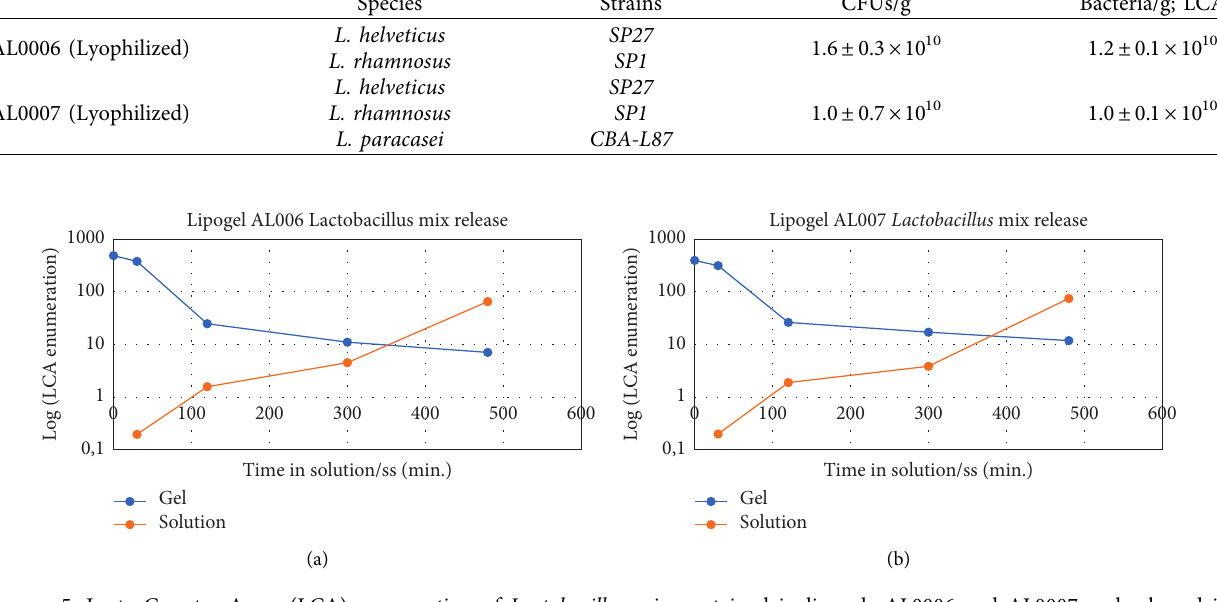
Figure 5: Lacto-Counter Assay (LCA) enumeration of Lactobacillus mix contained in lipogels AL0006 and AL0007 and released in physiological solution. Time T0 is referred to the quantity of lactobacilli present in the lipogels, while time points 30, 120, 300, and 480min refer to the quantity of bacteria remaining in the lipogels (1 g) or released in physiological solution (solution) (1g/ml) after each incubation